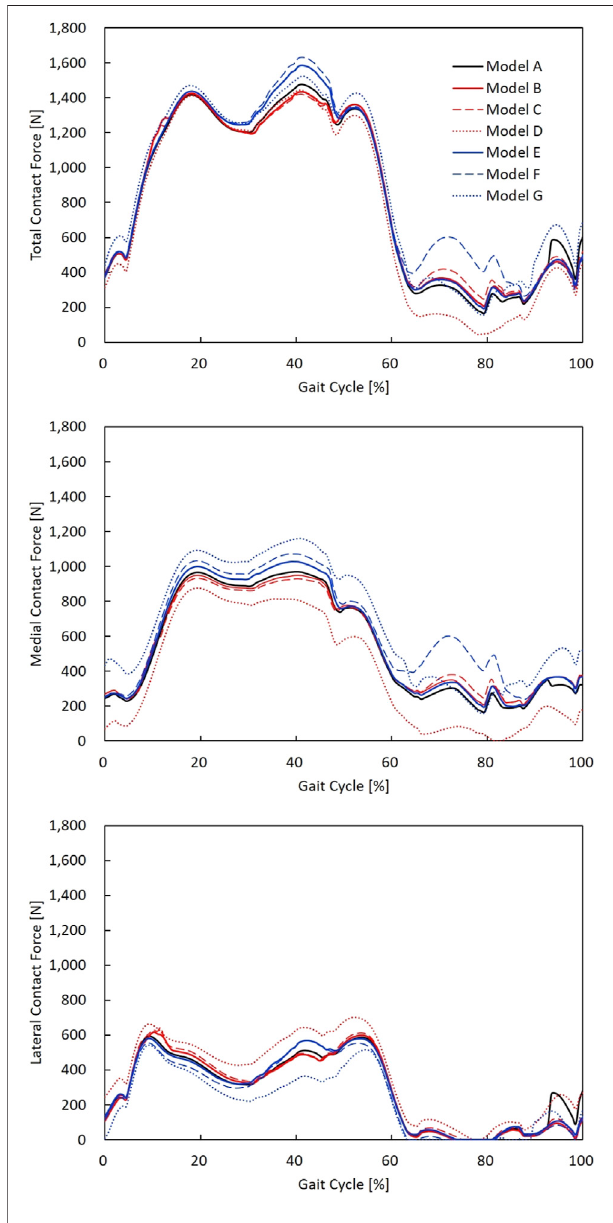
FIGURE5 | TCF, MCF, and LCF calculated during agait cycle inmodels A – G. The neutral alignment model (modelA); the2 ° tibial valgus (modelB) and femoral valgus (model C) alignment models with no laxity; the 2 ° tibial varus (model E) and femoral varus (model F) alignment models with no laxity; and neutral alignment models with 2 ° medial (model D) and lateral (model G) medially ( Figure 8F ). The tibial varus/valgus alignment showed to shift more than the femoral varus/valgus alignment. However, neutral alignment models with medial/ lateral laxity showed a less difference ( < 0.5 mm) than the varus/valgus alignment in the stance phase compared to the neutral alignment model.